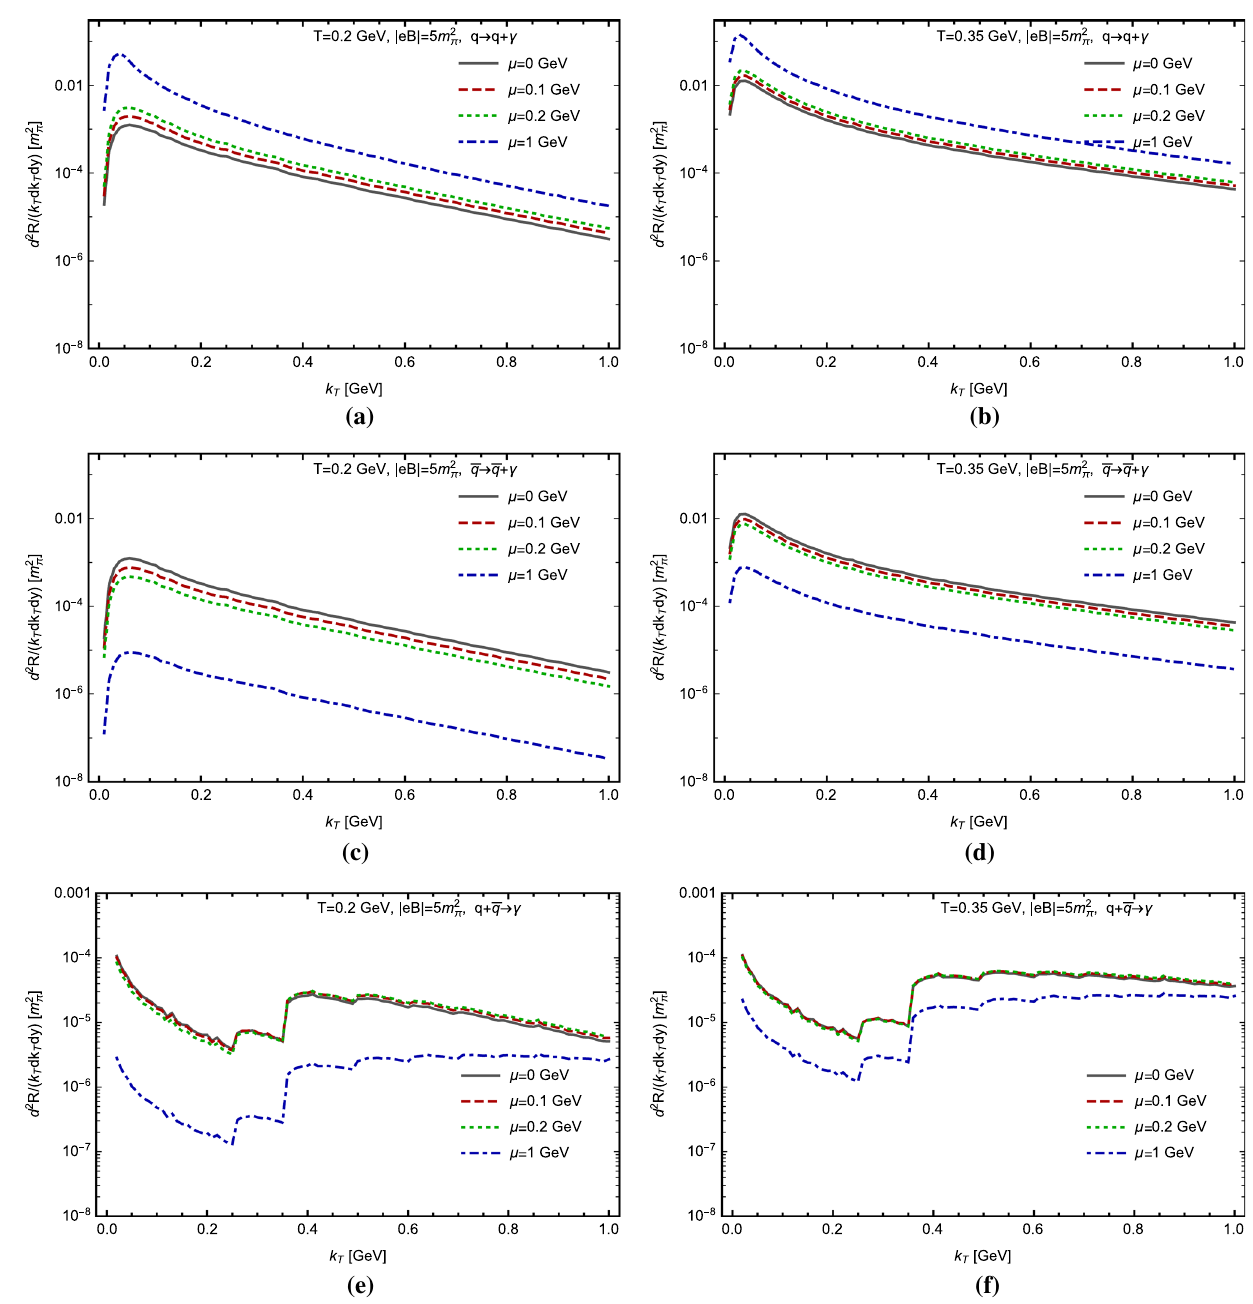
Fig. 5 Partialcontributionsofthethreetypesofprocessestothephoton production rate at | eB | = 5 m 2 π as functions of the transverse momen- tum k T for four different values of the chemical potential: μ = 0 (gray lines), μ = 0 . 1 GeV (red dashed lines), μ = 0 . 2 GeV (green dotted lines), and μ = 1 GeV (blue dot-dashed lines). The left panels ( a , c , e ) show the results for T = 200 MeV and the right panels ( b , d , f )